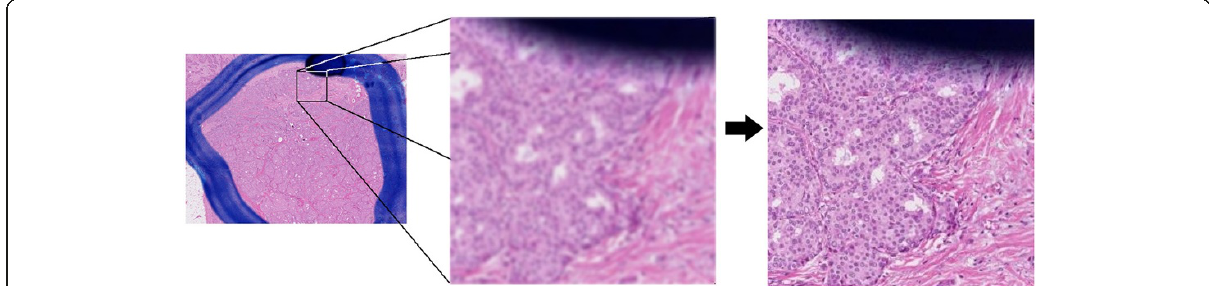
Figure 2 Deep Zoom overview: Using Deep Zoom the users can drill down to a higher level of zoom without any progress bar wait. The high resolution image loads in the background and seamlessly blends over the lower resolution